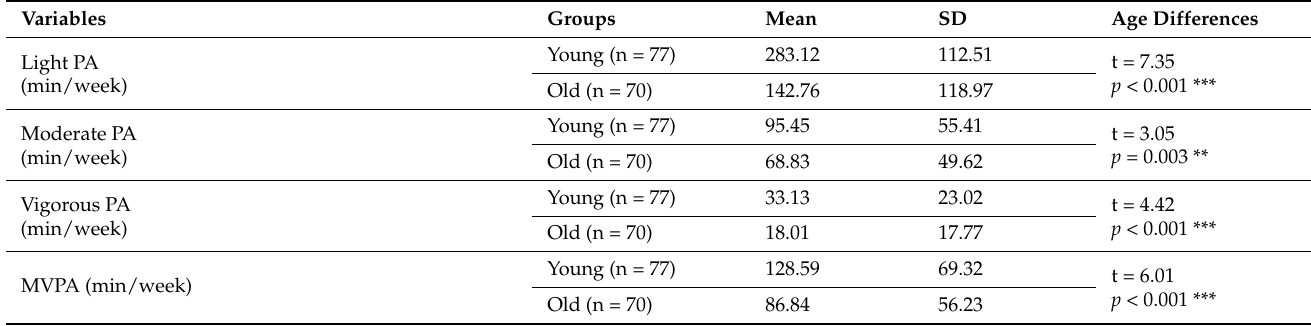
Table 2. Comparison of PA pattern, BI, and QoL among young and older